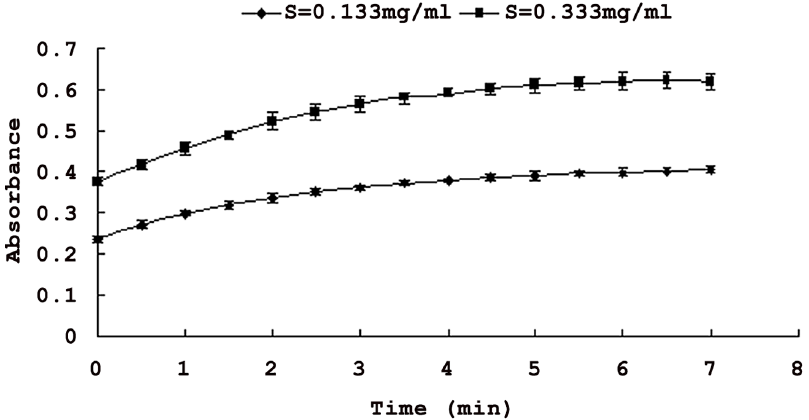
Figure 1. Progress of oxidation of L-DOPA catalyzed by tyrosinase vs. time. Each value is expressed as mean ± standard deviation (n=3).